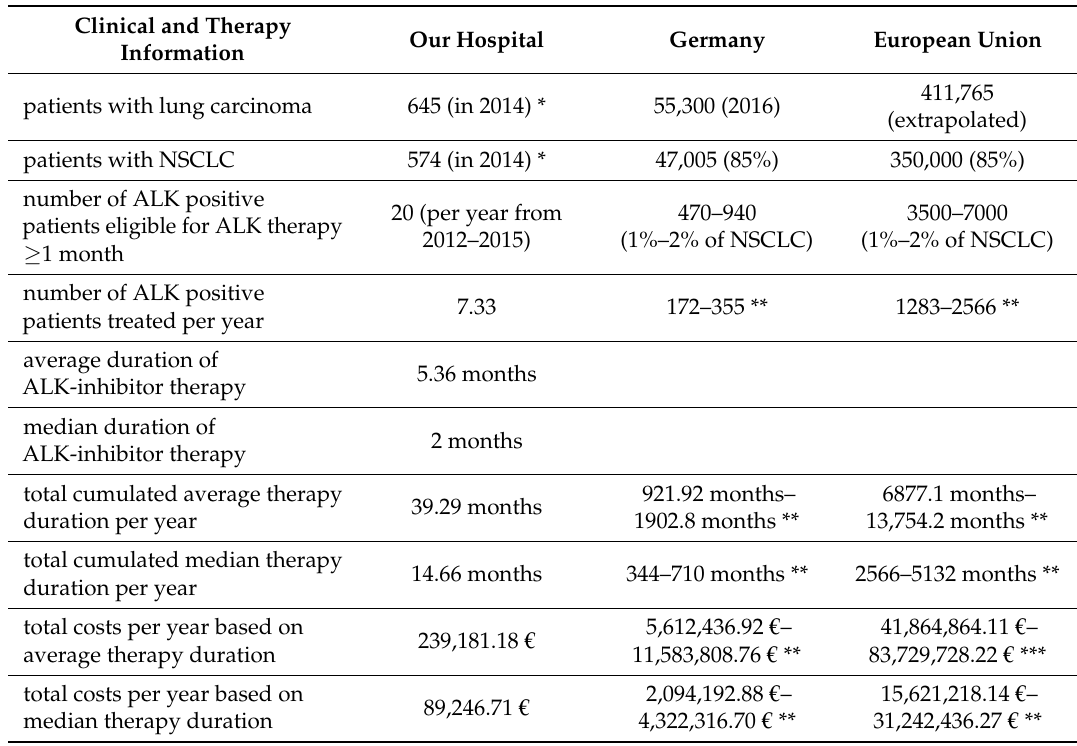
Table 2. Cost calculation for ALK-inhibitor therapy in our hospital and extrapolation of costs for Germany per year. * (data for 2015 and 2016 not fully available); ** (extrapolation based on the portion of patients under ALK-inhibitor therapy in our hospital); *** (These costs are a rough estimation as the costs for the drugs may vary between EU member